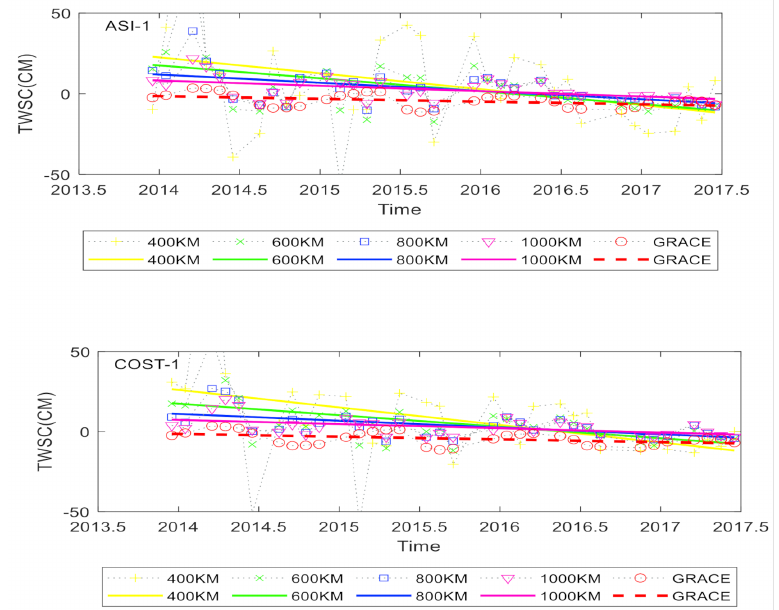
Figure 2. The Swarm-TWSC time series and the long-time trend with different filtering radius and GRACE-TWSC’s in Basin 1. The left one is Swarm from ASI and the right one is Swarm from COST. Table 2. The results of Swarm-TWSC of different filtering radius compared with GRACE-TWSC in Basin 1. Model ASI COST Filtering Radius (km) 400 600 Trend ( −